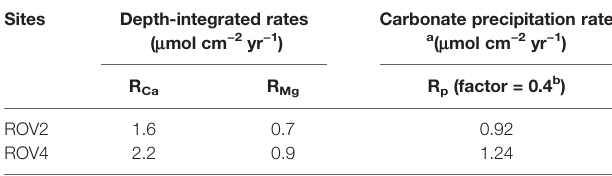
TABLE 2 | Depth-integrated rates of downward fl ux of Ca and Mg and converted carbonate precipitation rates.